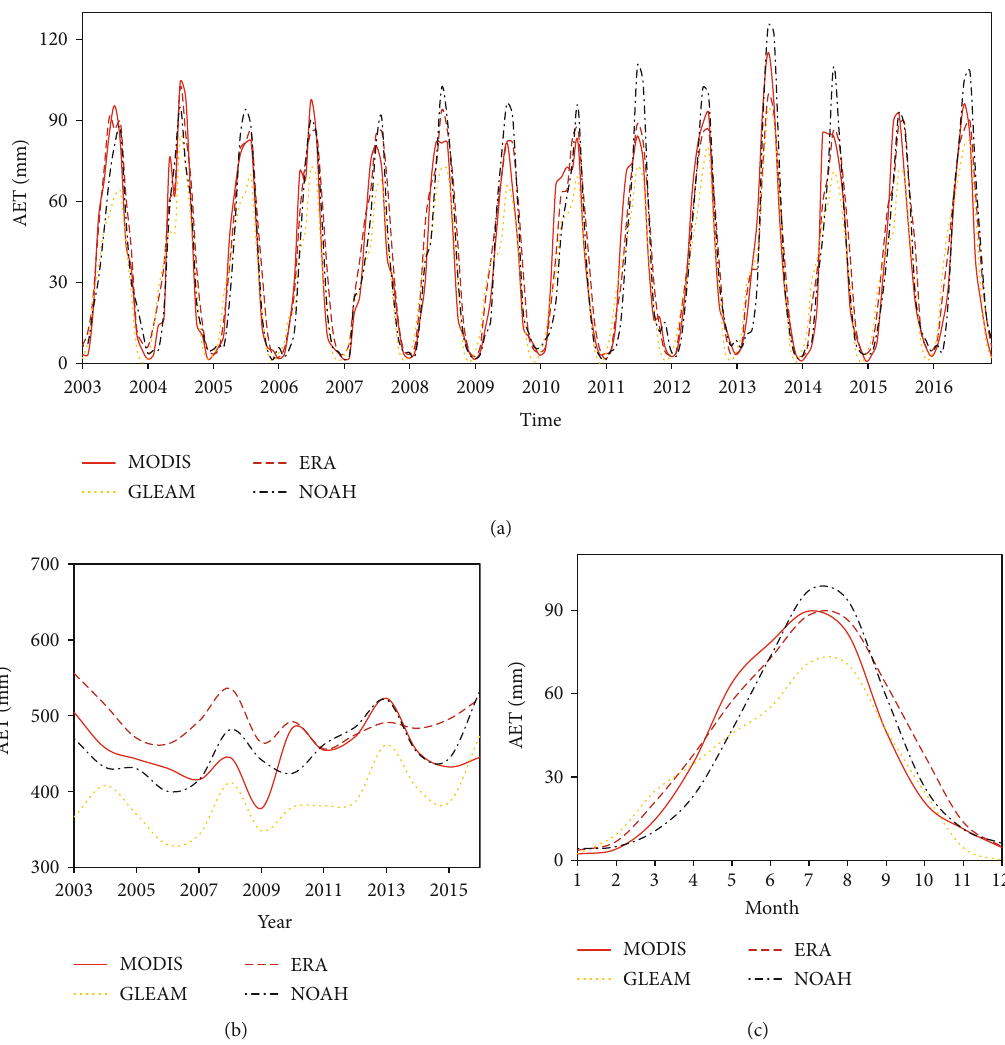
Figure 4: Comparison among four AET datasets from MODIS, GLEAM, ERA, and Noah: (a) monthly time-series data; (b) yearly time-series data; (c) mean seasonal time-series